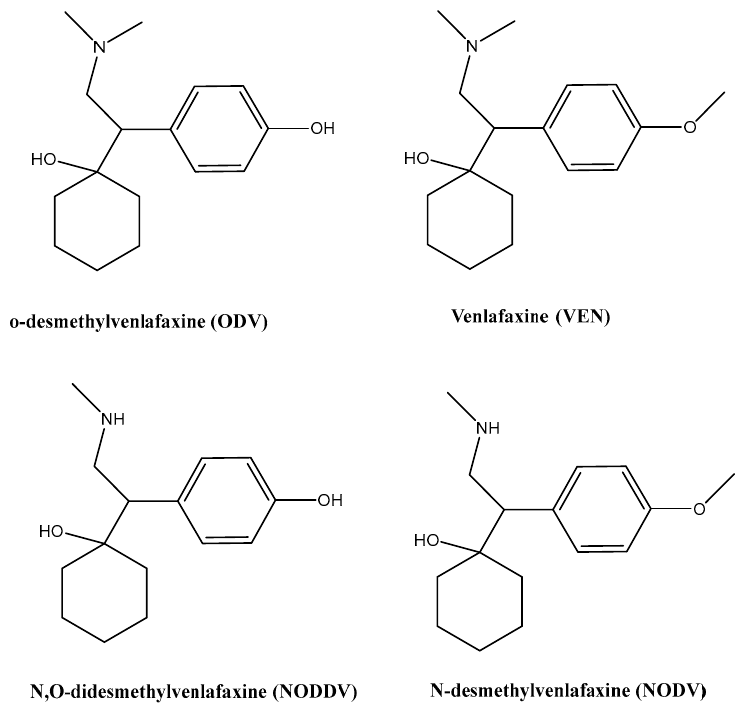
Figure 6. Chemical structures of venlafaxine and their metabolites.